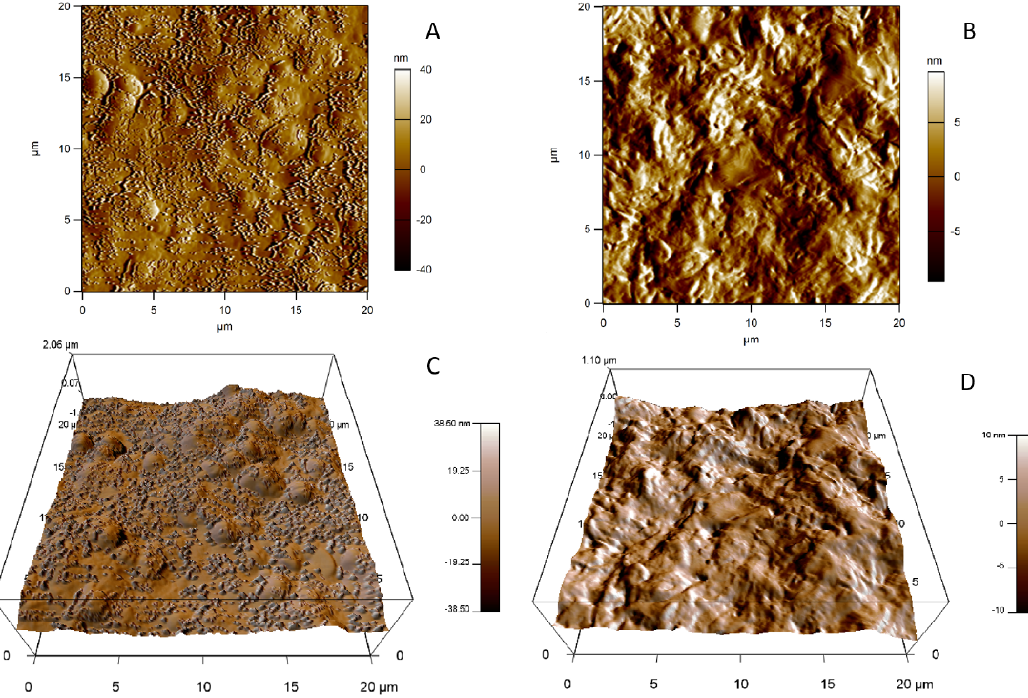
Figure 4. Topographic images of SLN-W ( A ) and SLN-Wb ( B ). Three-dimensional views of 20 × 20 µ m scan of SLN-W ( C ) and SLN-Wb ( D ).